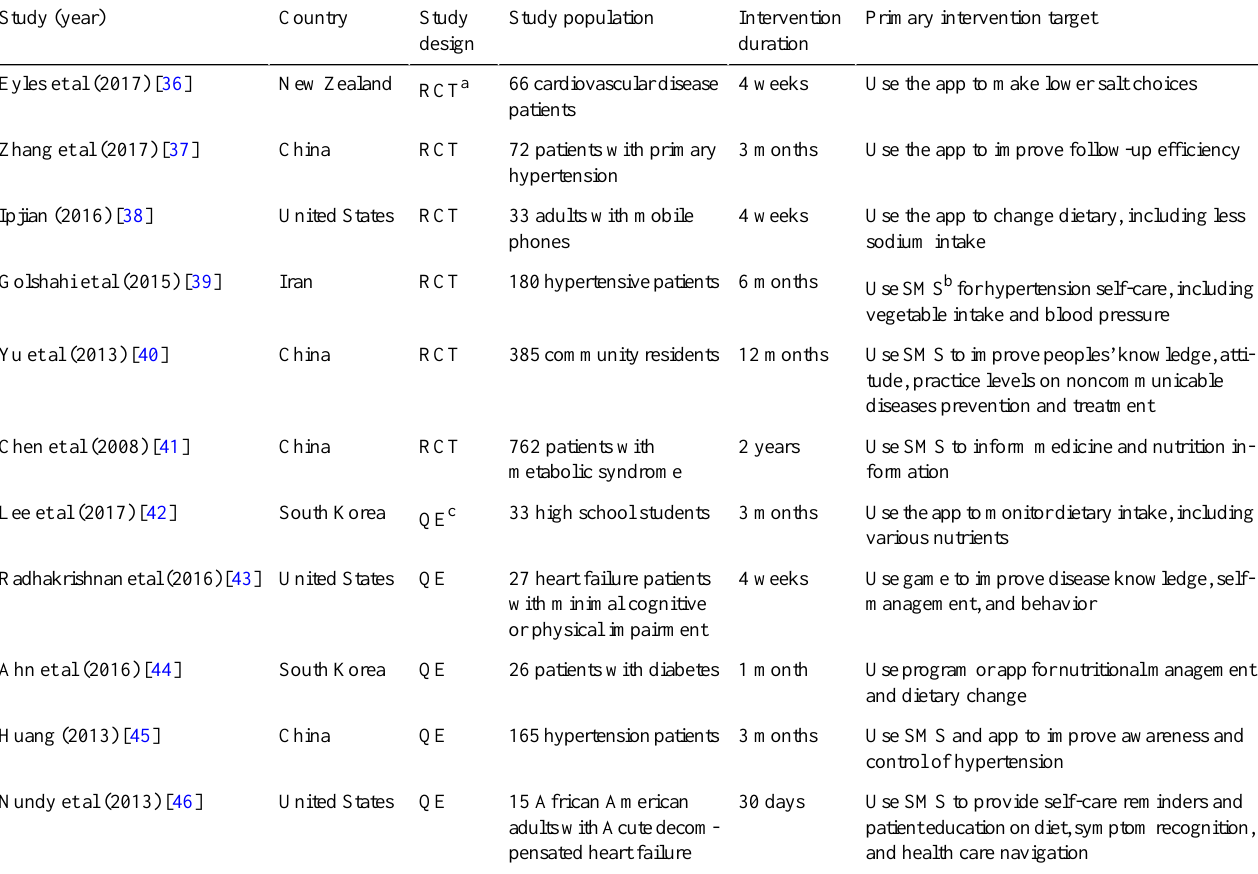
Table 1. Summary of key characteristics of included studies